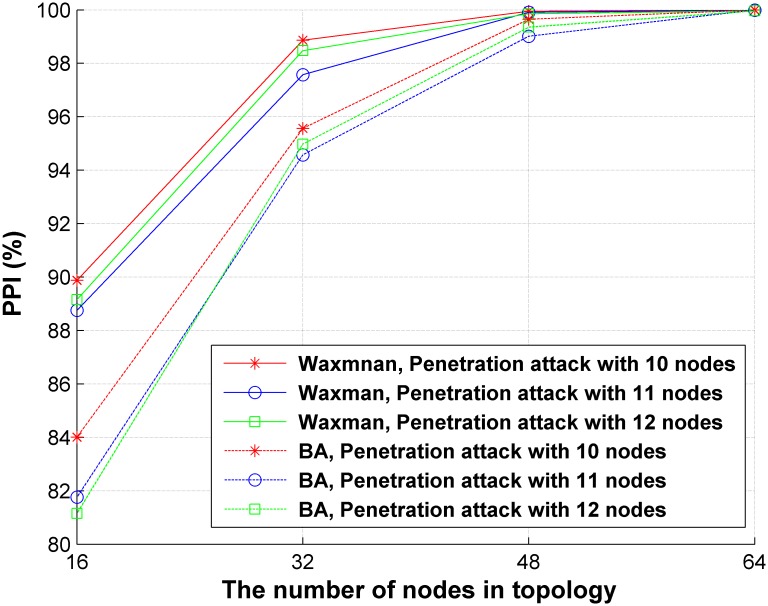
Comparison of PPI with different topologies and ξ.